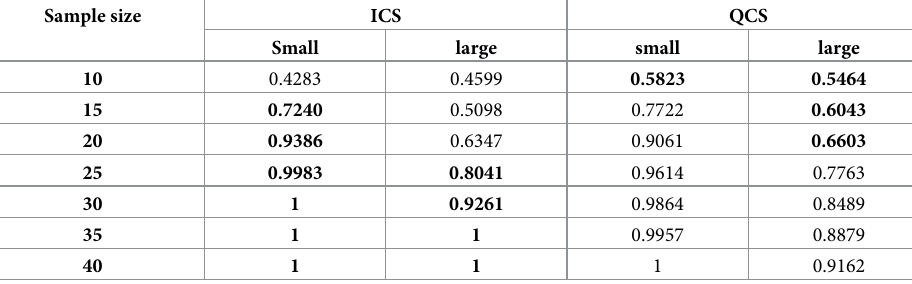
Table 2. Accuracy of QCS and ICS models on large and small